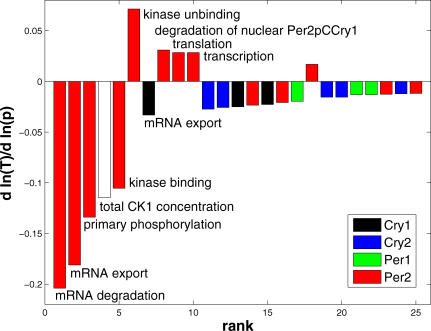
Top 25 Ranked Sensitivities Ordered by Relative Period SensitivityBlack bars indicate Cry1-related parameters, blue bars indicate Cry2-related parameters, green bars indicate Per1-related parameters, and red bars indicate Per2-related parameters. The white bar represents a single, special parameter representing the total kinase concentration. Where Cry- and Per-related parameters overlap, the Per species colors are shown. “Per2pCCry1” describes a complex of once-phosphorylated PER2 with the kinase C and CRY1.